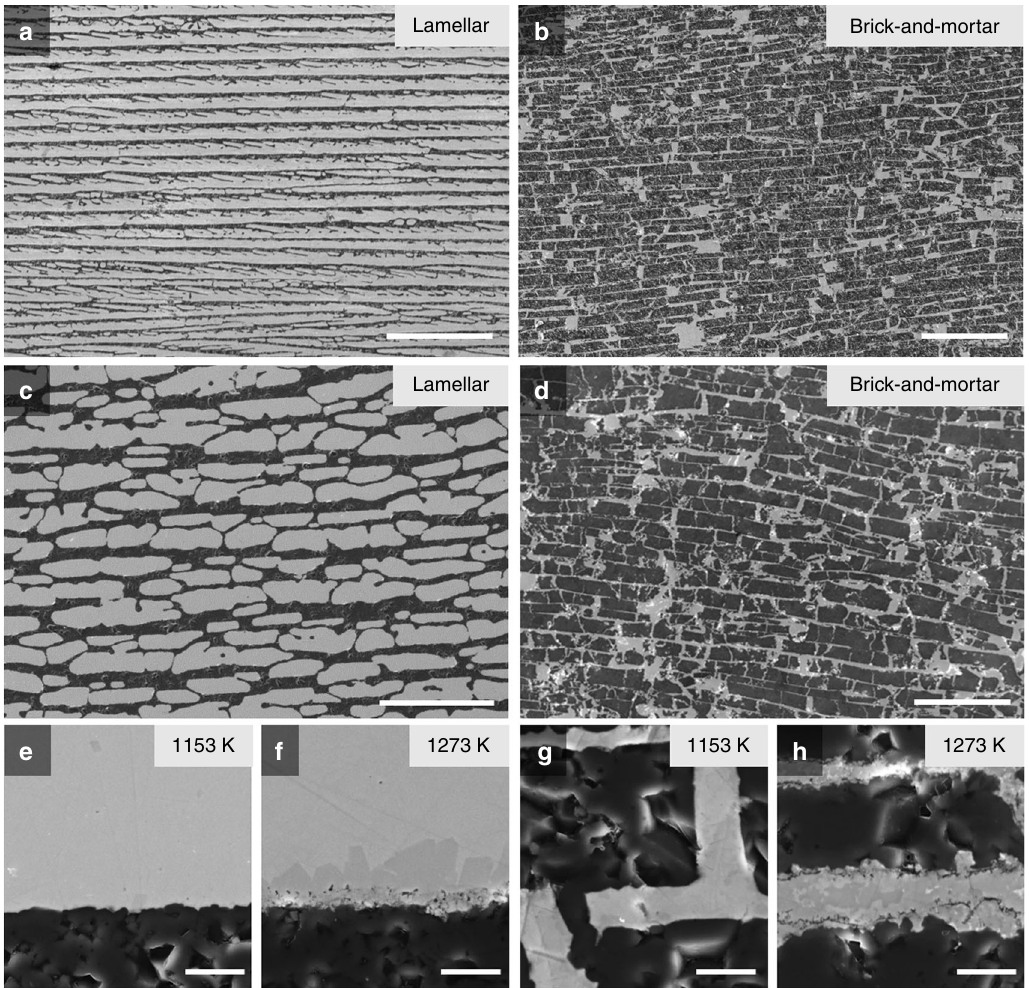
Fig. 4 SEM micrographs of the alumina/BMG-alloy materials. a – d Lamellar ( a , c ) and brick-and-mortar structures ( b , d ). e – h The metal – ceramic interfaces in these ceramics in fi ltrated at 1153 K and 1273 K are shown in e and f for a lamellar structure and g and h for brick-and-mortar structures, respectively. The materials in fi ltrated at 1153 K ( e , g ) show a sharp interface between the alumina (black) and amorphous phase (gray), but the materials in fi ltrated at 1273 K ( f , h ) show erosion of the alumina surface and voids at the interface. Scale bars: 300 μ m ( a , b ), 100 μ m ( c , d ), 5 μ m ( e , f , g , h